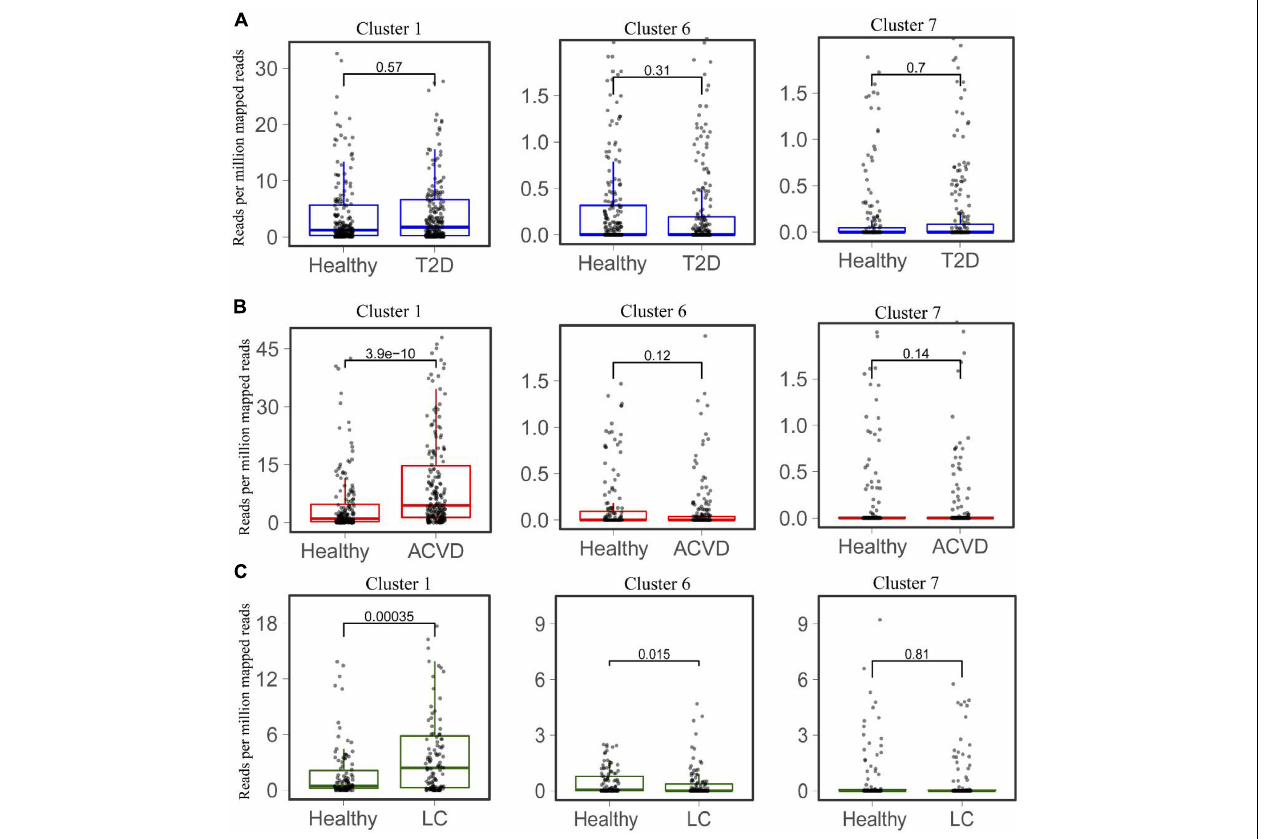
FIGURE 4 | Comparison of the abundance of HepIs from different clusters in the human gut microbiome between a healthy group and a disease group. The metagenomic datasets from the disease conditions; Type 2 diabetes T2D (A) , cardiovascular disease CVD (B) , and liver cirrhosis LC (C) are used to map the genes of HepIs from Cluster 1, 6, and 7. The paired Wilcoxon test was used to calculate the p -value for significant